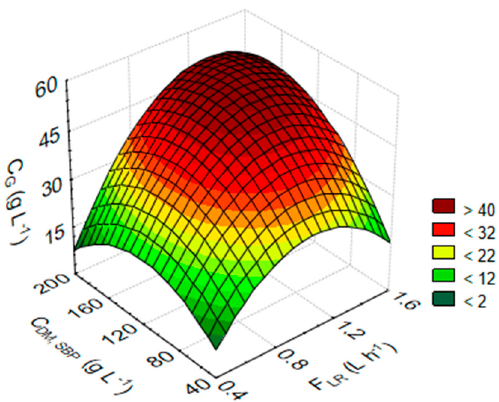
Figure 2. Changes in sugar concentrations in the hydrolysis step with investigated factors (recycling ratio and solid concentration).